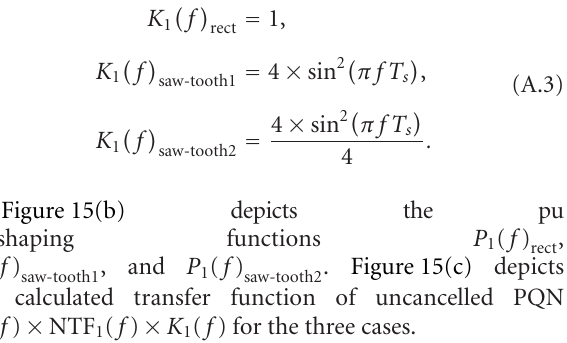
phase quantization noise cancellation were presented with emphasis on advancement of cancellation signal, reduction in integration time, and impact of quantization in the cancellation signal. In the final system, the residual PQN for a 2nd-order Σ − Δ quantized digital phase modulator was lower by 27 dB. Inclusion of a noise transfer function notch was presented to meet the specification of receive band noise in a digital phase modulator.